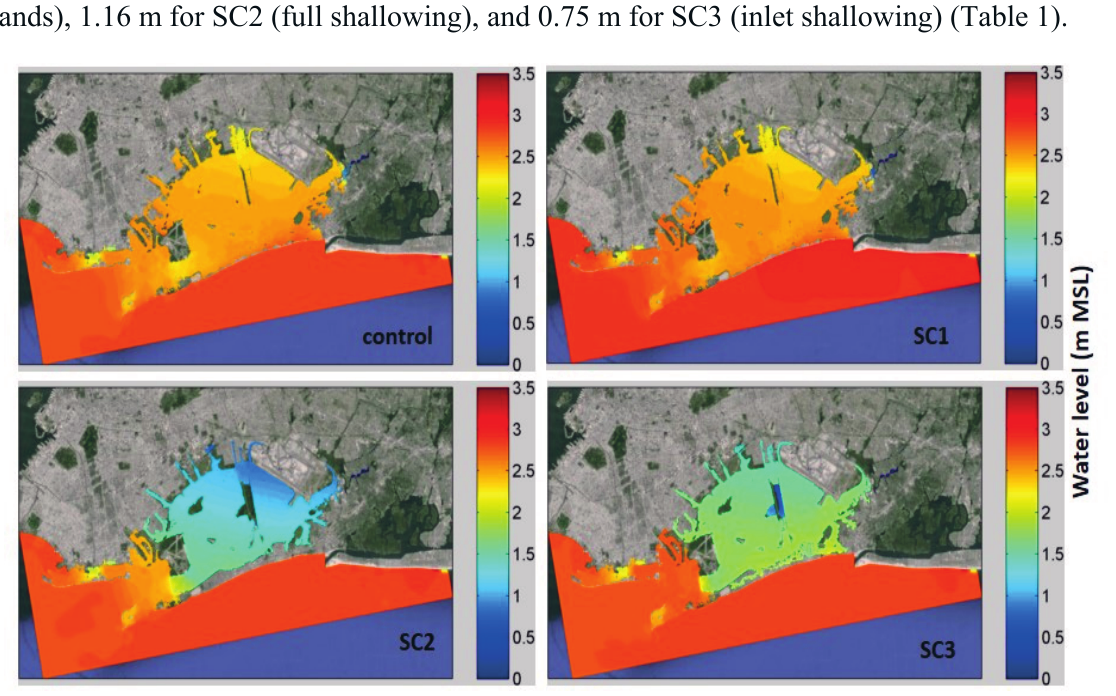
Figure 7. Results for the 1821 Hurricane (peak water level) in map view for control run and scenarios 1, 2 and 3, as with Figure